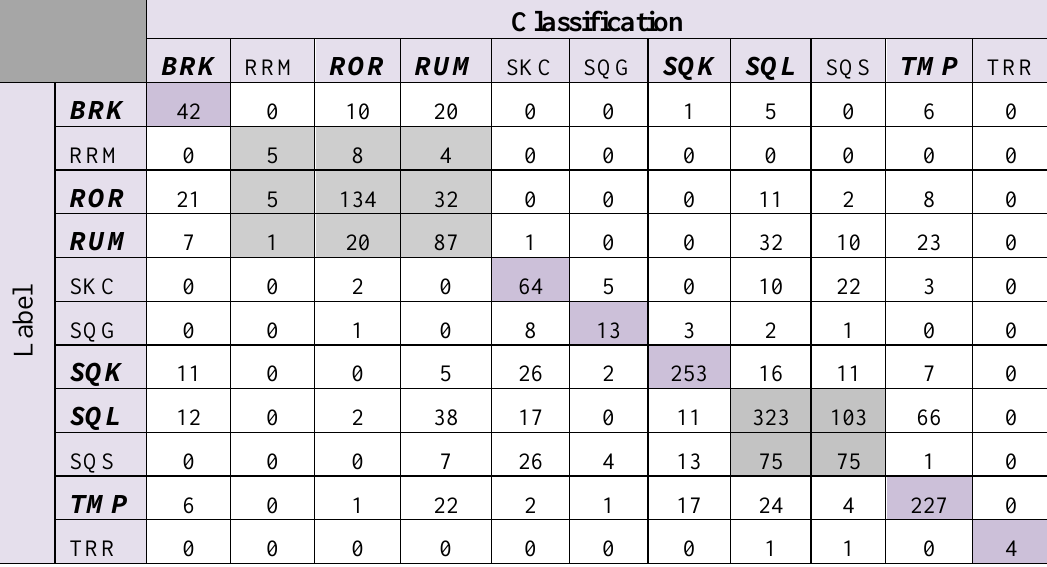
Table 1. Confusion matrix for 12 state HMM with 3 mixtures. Basic call types are shown in bold. BRK=Bark, RRM=Roar-Rumble, ROR=Roar, RUM=Rumble, SKC=SqueakTrain, SQG=Squeak-Bark, SQK=Squeak, SQL=Squeal, SQS=Squeak-Squeal,